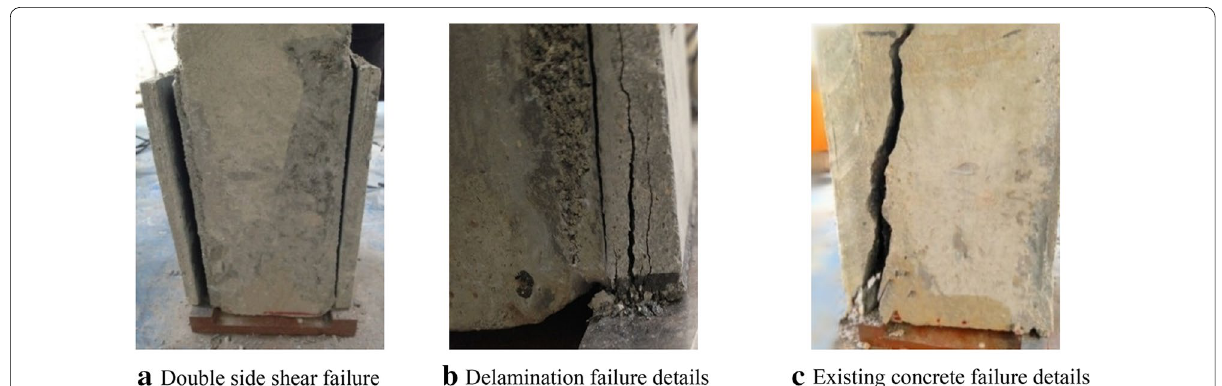
Fig. 3 Macroscopic characteristics of the interface